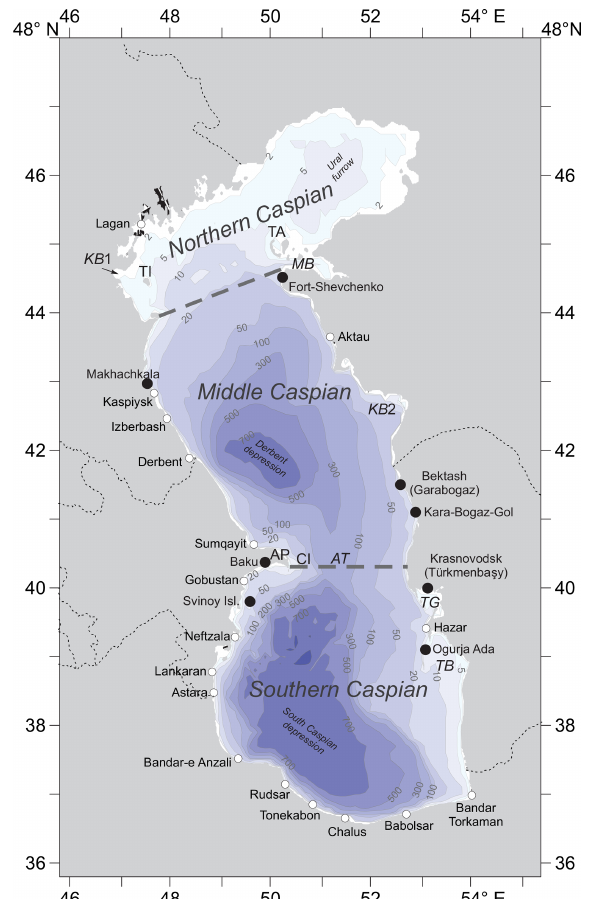
Figure 1. The bathymetry of the Caspian Sea according to the GEBCO database. Numbers on the contours indicate the depths below mean sea level (MSL), which is − 28m with respect to the Baltic Height System (BHS). Black points denote sites of tide gauges used for validation of the numerical model. Other designa- tions are given: TI is Tyulen’i (Tyuleny) island, TA is the Tyulen’i (Tyuleniy) archipelago, MB is Mangyshlak bay, KB1 is Kizlyar bay, KB2 is Kazakh bay, AP is the Absheron Peninsula, AT is the Ab- sheron Threshold, CI is the Chilov (Zhiloy) island, TG is Türkmen- ba¸sy Gulf, and TB is Turkmen